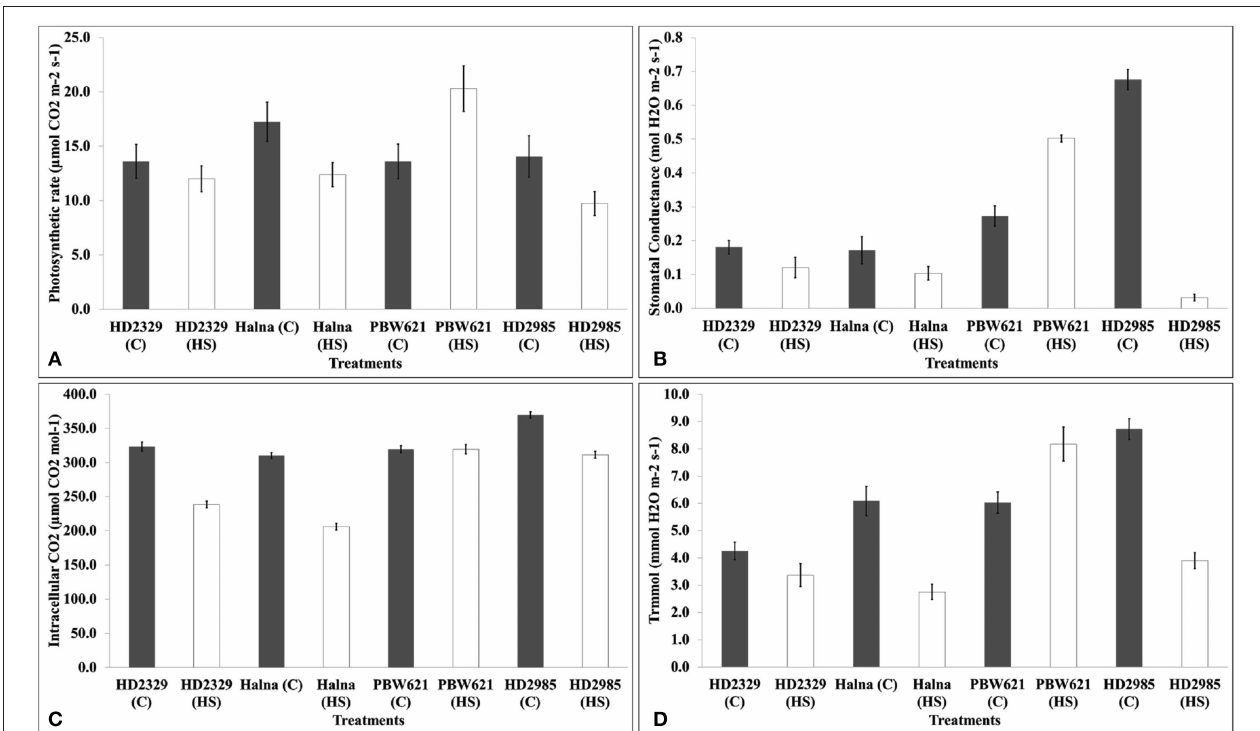
FIGURE 4 | Infra-Red Gas Analyzer (IRGA) analysis of full expanded leaves of different wheat cvs . under control and heat stress conditions. (A) Photosynthetic rate, (B) Stomatal conductance, (C) Intracellular carbon dioxide, (D) Transpiration rate; C − 22 ± 3 ◦ , heat stress –42 ◦ C for 2 h; Leaves of HD2985, HD2329, Halna and PBW621 were used for the analysis; vertical bars indicate SE ( n = 3